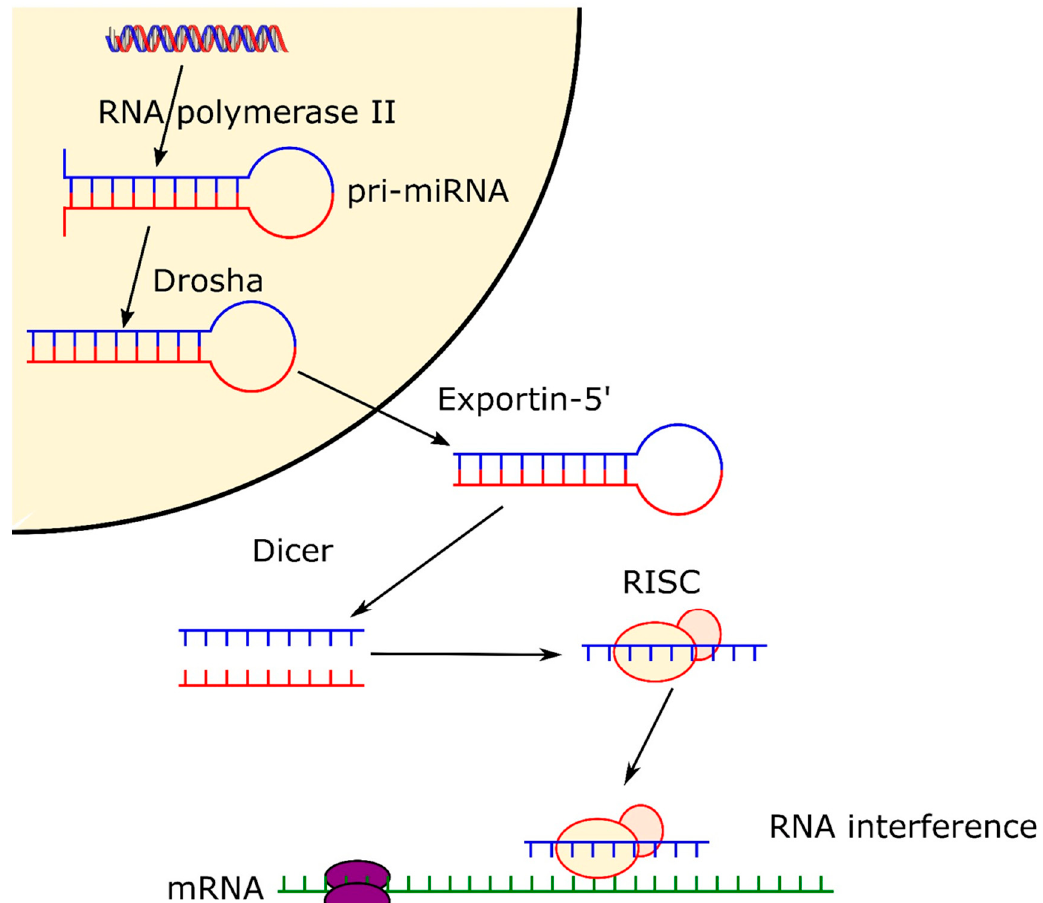
Figure 1. Pathway of microRNA, from formation in the cell nucleus thanks to RNA polymerase II, to formation of RISC complex and expression.